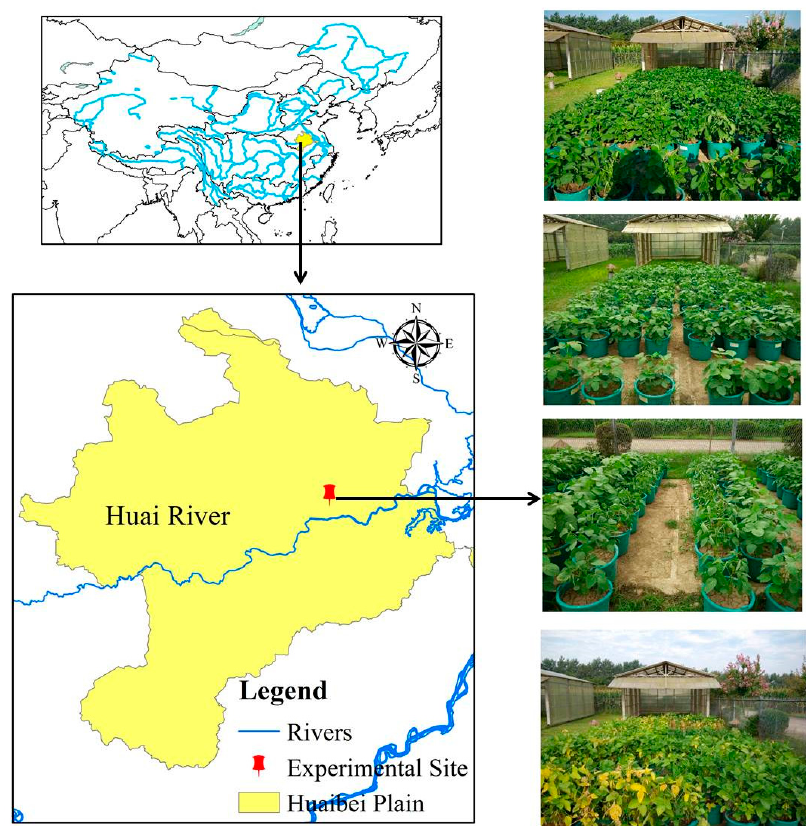
Figure 1. Location of experimental site and soybean pots under drought stress in the Huaibei Plain.